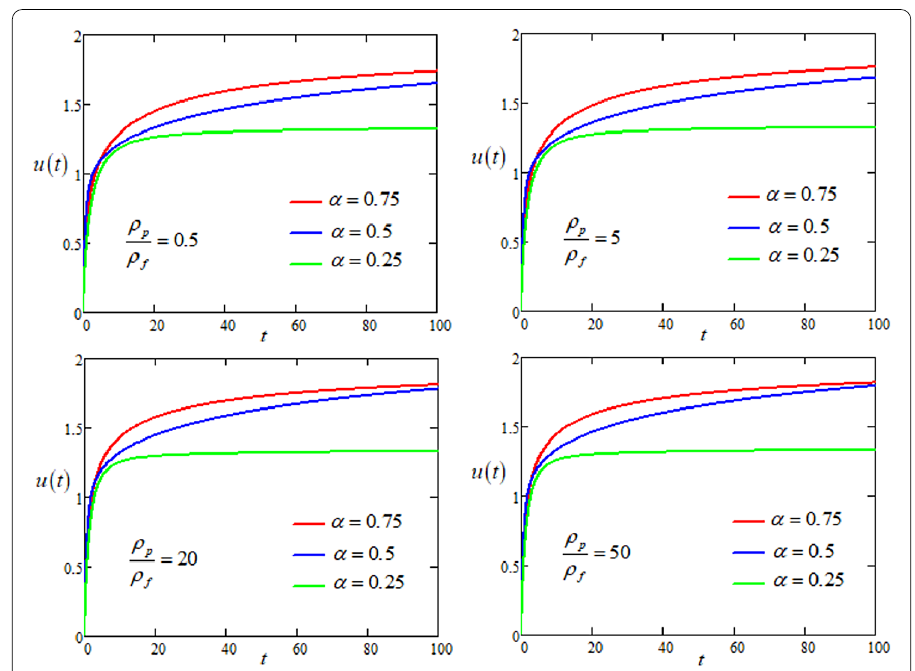
Figure 3 Profiles of velocity versus time for the case of Atangana–Baleanu derivative operator with ρ p ρ t = 0.5,5,20,50